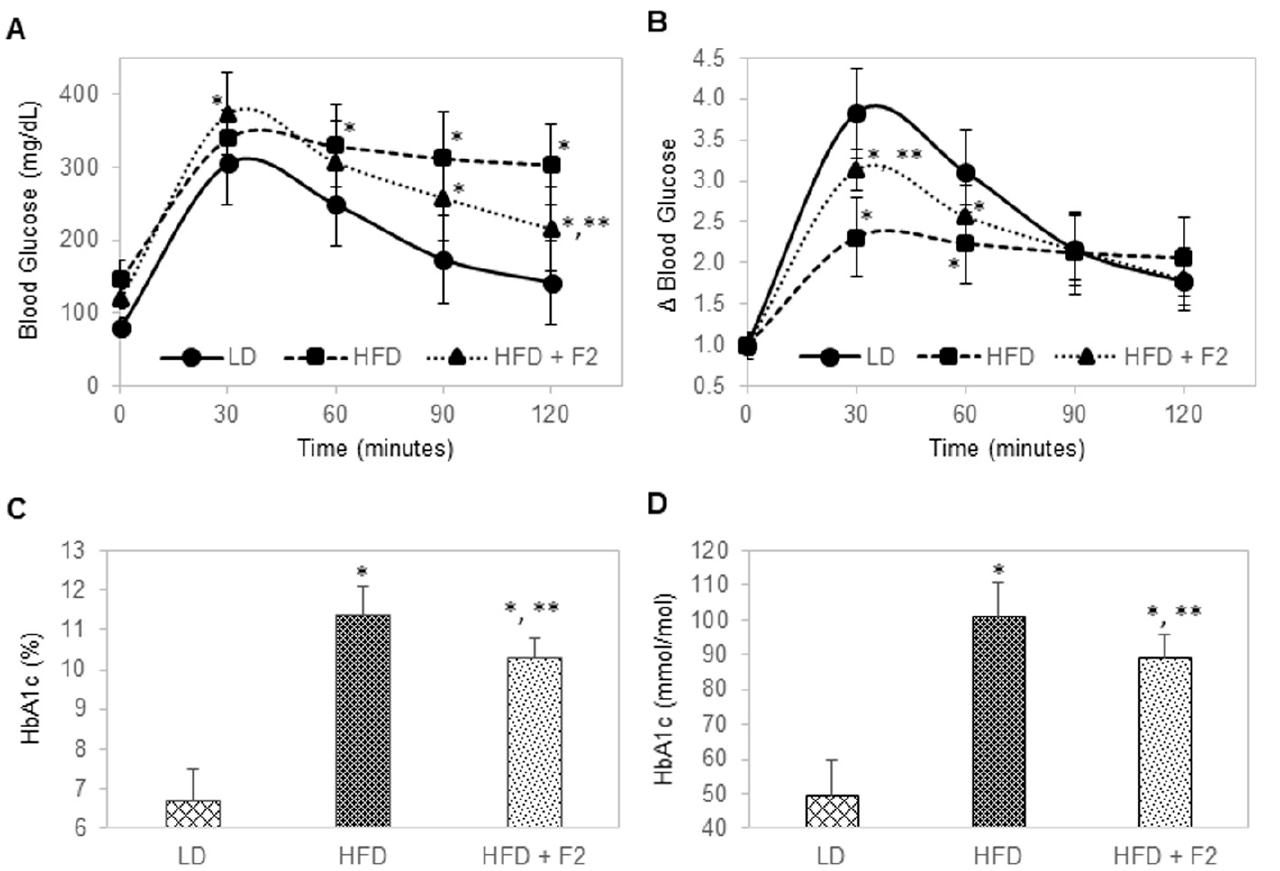
Figure 6. F2 composition improves glucose tolerance and reduces HbA1c in diet-induced obesity mice. ( A ) Blood glucose level as a function of time post-injection. ( B ) Fold change in blood glucose level as a function of time post-injection. ( C ) HbA1c (%) and ( D ) HbA1c (mmol/mol) as a function of animal groups. LD: Lean diet; HFD: High-fat diet; HFD + F2: High-fat diet supplemented with F2. The error bars indicate the standard deviations of 40 mice per animal group. Single asterisk (*) indicates a statistical significance of p -value ≤ 0.01 versus the lean diet group. Double asterisk (**) indicates a statistical significance of p -value ≤ 0.01 versus the high-fat diet group.